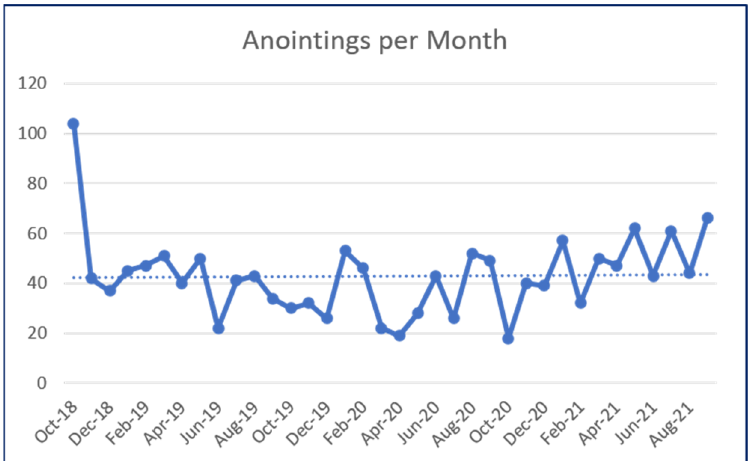
Figure 4. Anointings per month.